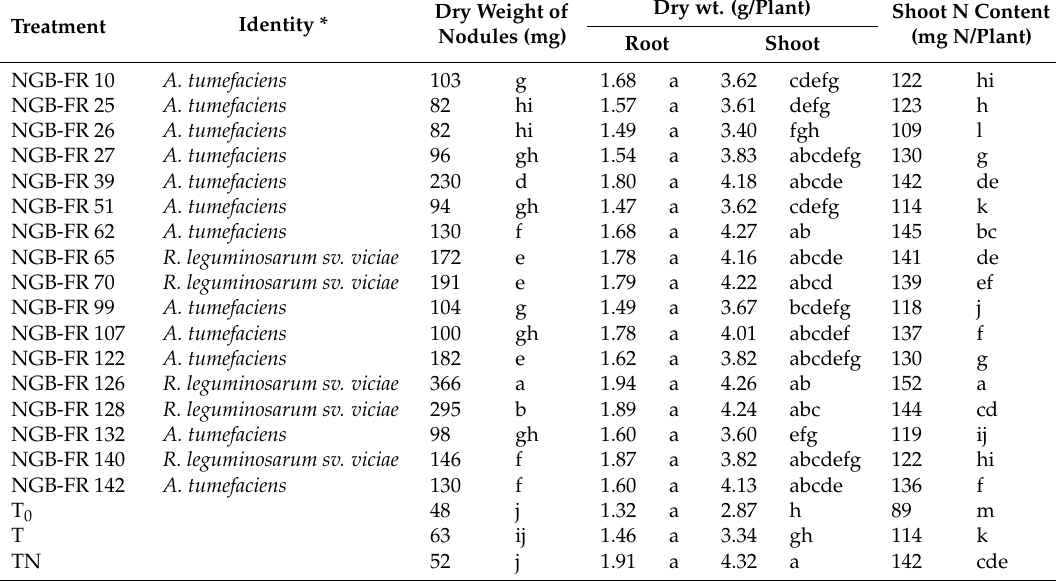
Table 2. List of faba bean nodulating rhizobia used in this study, their identity *, and symbiotic properties under greenhouse